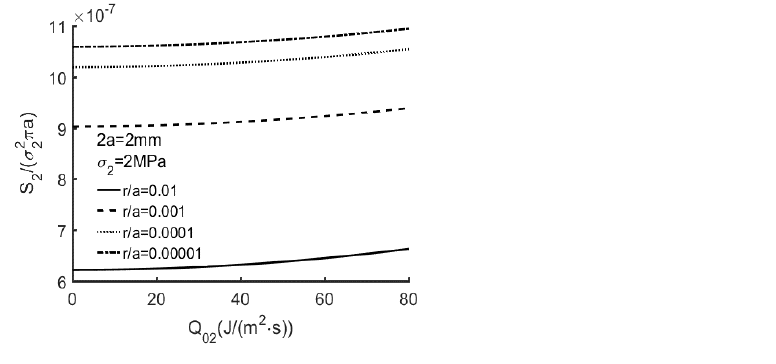
Figure 11. S 2 /( σ 22 π a ) versus 𝑄 02 with 𝑟/𝑎 = 0.01,0.001,0.0001,0.00001 for 𝜛 𝑐 and 𝜀 = 0.01. (2 a = 2 mm, 𝜎 2 = 2 MPa).